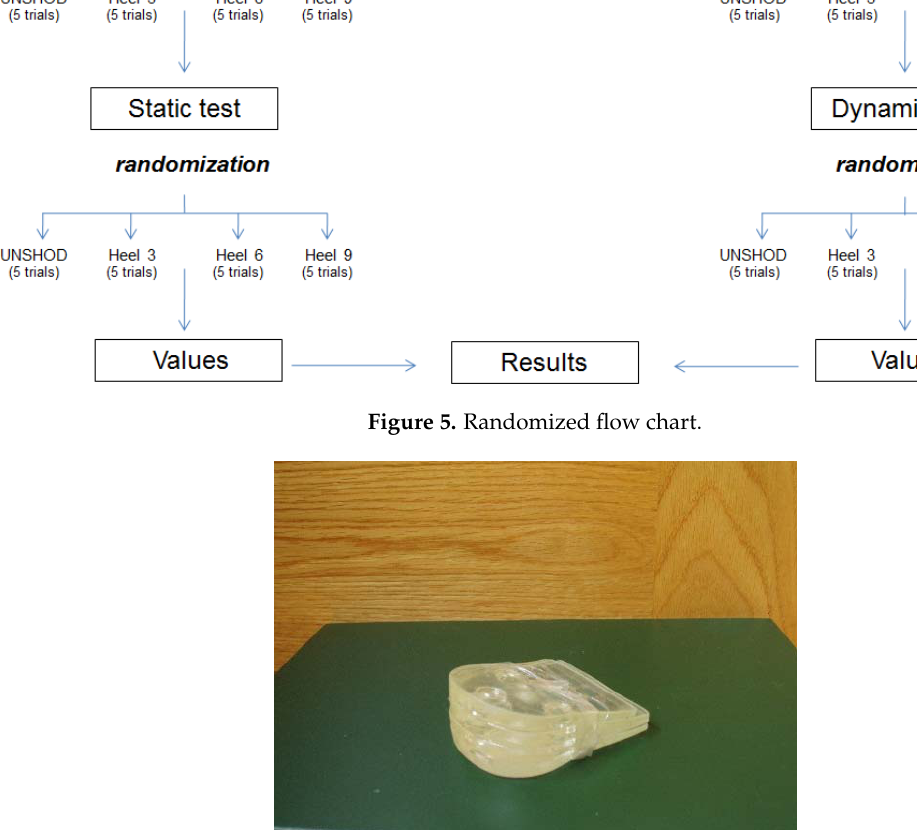
Figure 6. Prefabricated high ‐ heels. The heels were made on hard silicone. The additional height was added over the top.